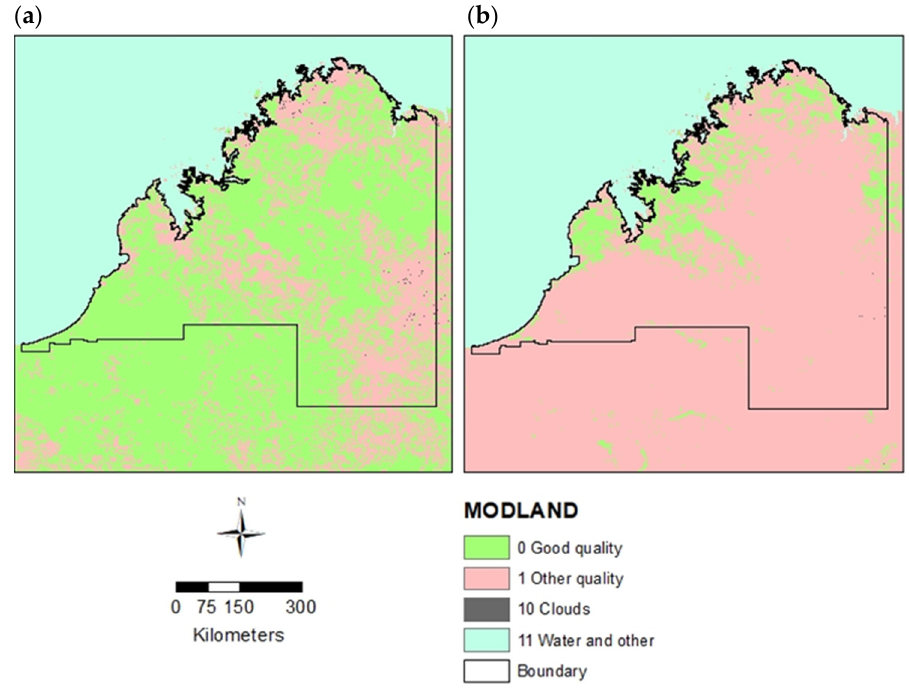
Figure 13. Image date 2019009 , Kimberley summer, day MODLAND quality comparison: ( a ) MYD21A2 and ( b ) MYD11A2.